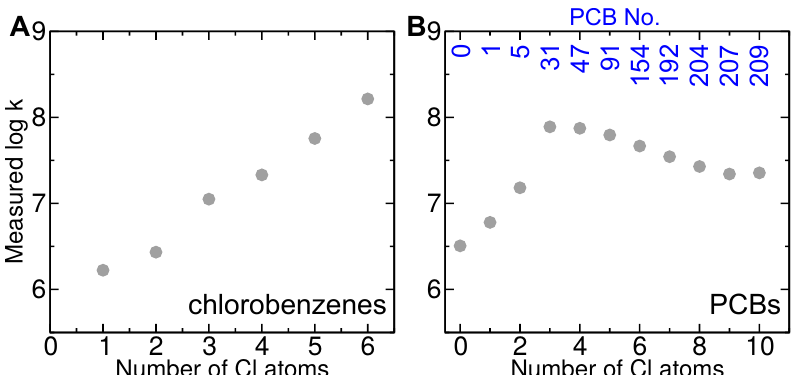
Figure 3. Contribution of the numbers of chlorine atoms of aromatic organochlorines to their adsorption coefficients (log k ) on ZnO NPs as determined by GC/MS/MS. The concentration of ZnO NPs was 0.8 mg/L and the concentration of the aromatic organochlorines was 0.05 mg/L. ( A ) Adsorption coefficients of chlorobenzene, 1,4-dichlorobenzene, 1,3,5-trichlorobenzene, 1,2,4,5- tetrachlorobenzene, pentachlorobenzene, and hexachlorobenzne. ( B ) Adsorption coefficients of biphenyl and 10 ortho -substituted